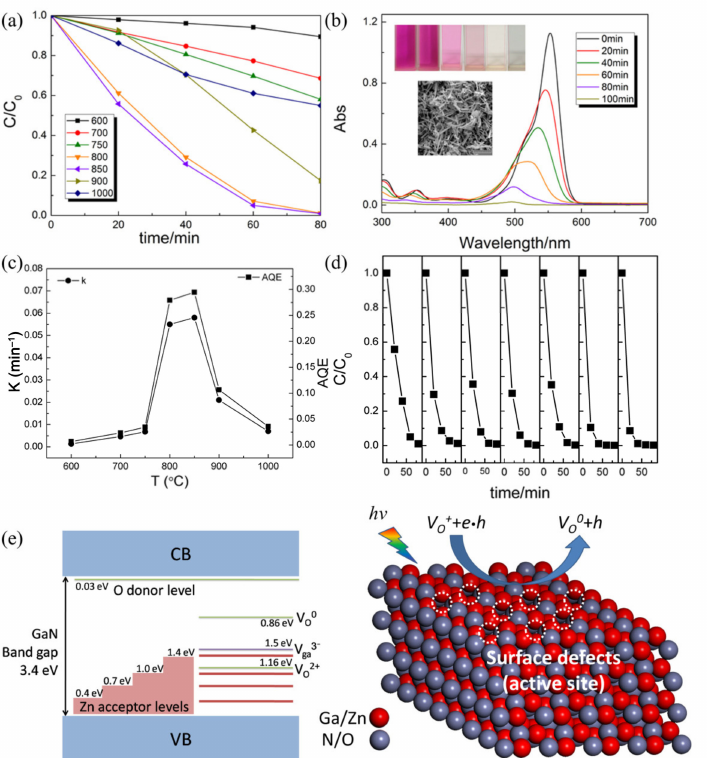
Figure 14. ( a ) Photodegradation of RhB by zinc-doped gallium oxynitride nanowires calcined at different temperatures; ( b ) the absorption spectrum of the RhB solution in the presence of the nanowires. The inset illustrates photos for the RhB solutions photodegraded for different times and the SEM image of the specimen reclaimed after photocatalytic measurement; ( c ) degradation rate constants and apparent quantum efficiencies for the nanowires; ( d ) the repeatability tests of the specimen calcined at 850 ◦ C; ( e ) schematic illustrations of the surface defect-related photocatalytic mechanism for zinc-doped gallium oxynitride nanowires. (Redrawn with the permission of Ref. [56]. Copyright 2017 Elsevier